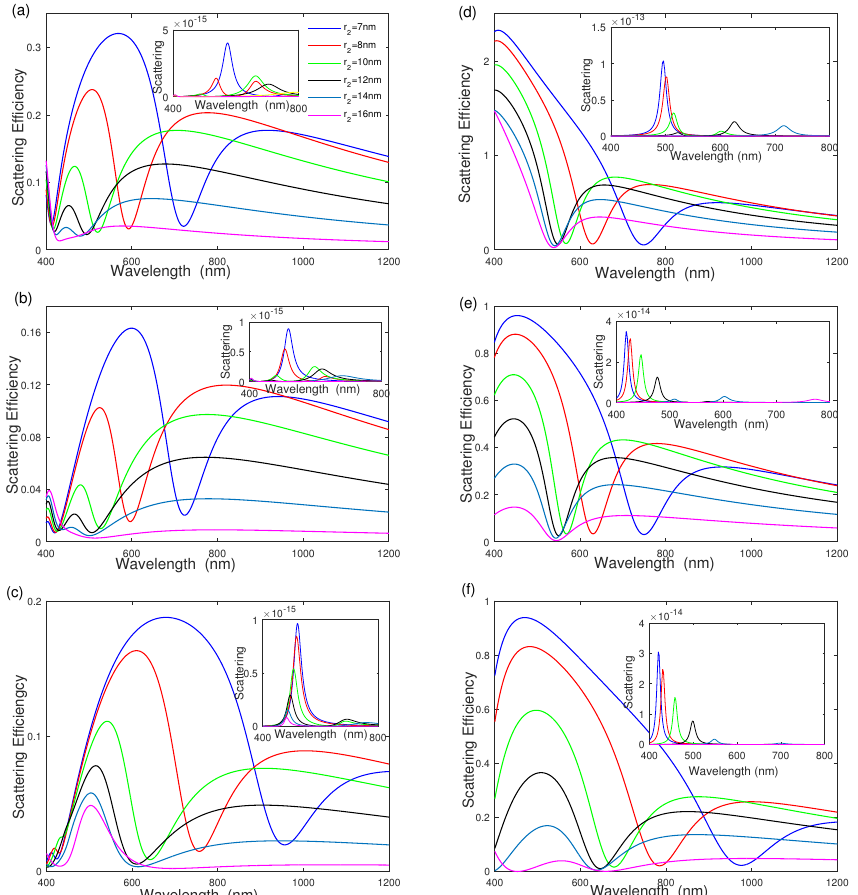
Figure 4. The effect of middle dielectric layer thickness r 2 − r 1 on scattering efficiency and scattering. ( a – c ) Silver–dielectric–gold nanoshell with [ ε 2 , ε 4 ] = [ 4.0,2.0 ] , [ ε 2 , ε 4 ] = [ 2.0,2.0 ] , and [ ε 2 , ε 4 ] = [ 2.0,4.0 ] . ( d – f ) Gold–dielectric–silver nanoshell with [ ε [ ε ] = [ 2.0,4.0 ] , 2 , ε 4